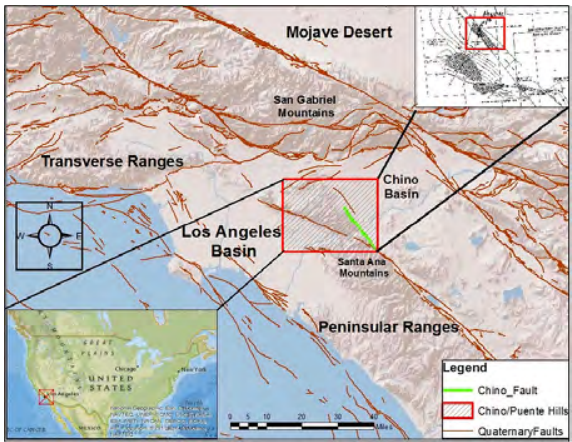
Figure 1. Location map of the study area